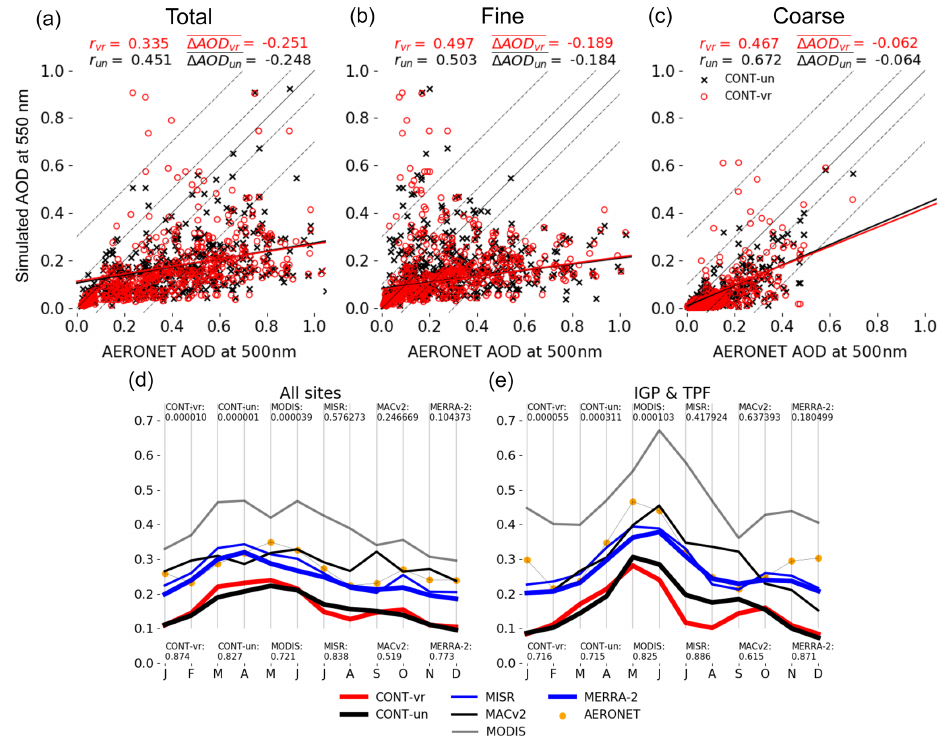
Figure 3. Measurements from AERONET compared to CESM simulations for (a) total, (b) fine-mode, and (c) coarse-mode annually av- eraged AOD. Pearson correlation ( r ) values between simulations and observations are given, as are mean AOD differences ( (cid:49) AOD). The p values are not given for panels (a) through (c) , as they are very close to zero. A best-fit line for the scatter data between CONT-vr (CONT- un) is plotted in red (black). The thin black line is the 1-to-1 curve. Panels (d) and (e) show the mean monthly variability of AOD averaged at all 57 AERONET sites and only for sites between 25 and 30 ◦ N and 70 and 90 ◦ E, respectively. r values ( p values) between various simulations/observations and AERONET are also given in panels (d) and (e) at the bottom (top) of each panel.